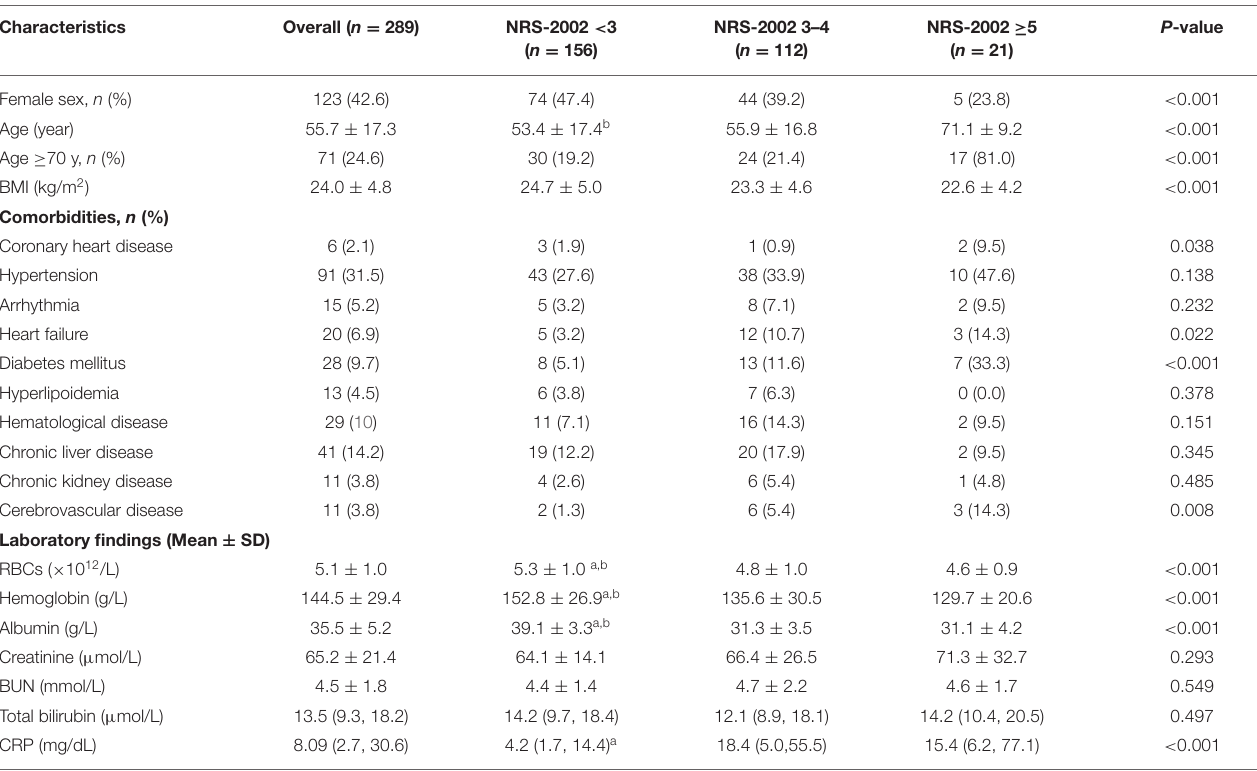
TABLE 2 | Clinical characteristics by NRS-2002 score.